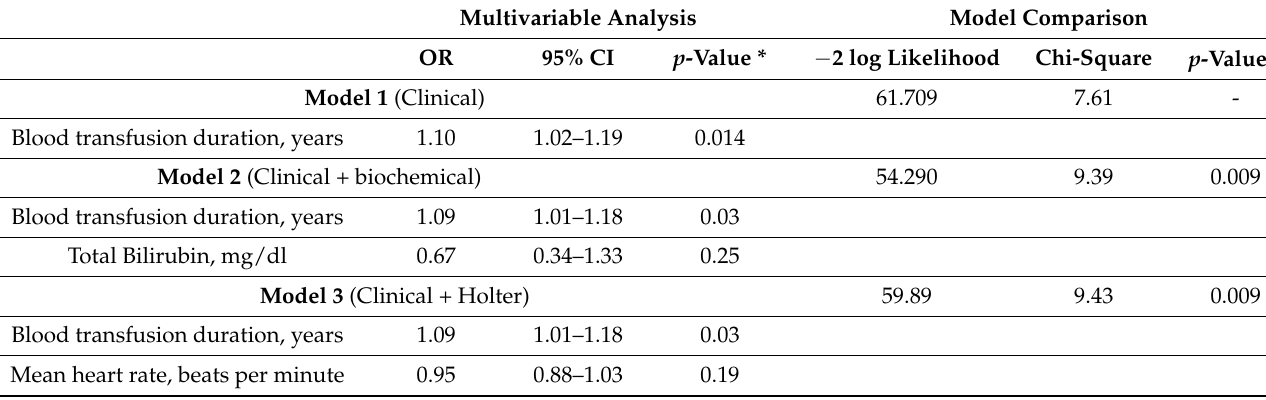
Table 4. Models of clinical and biochemical or 24-hour-Holter or echocardiography or cardiac magnetic resonance T2* associates of premature atrial contractions > 24/day in β -thalassemia-major patients.